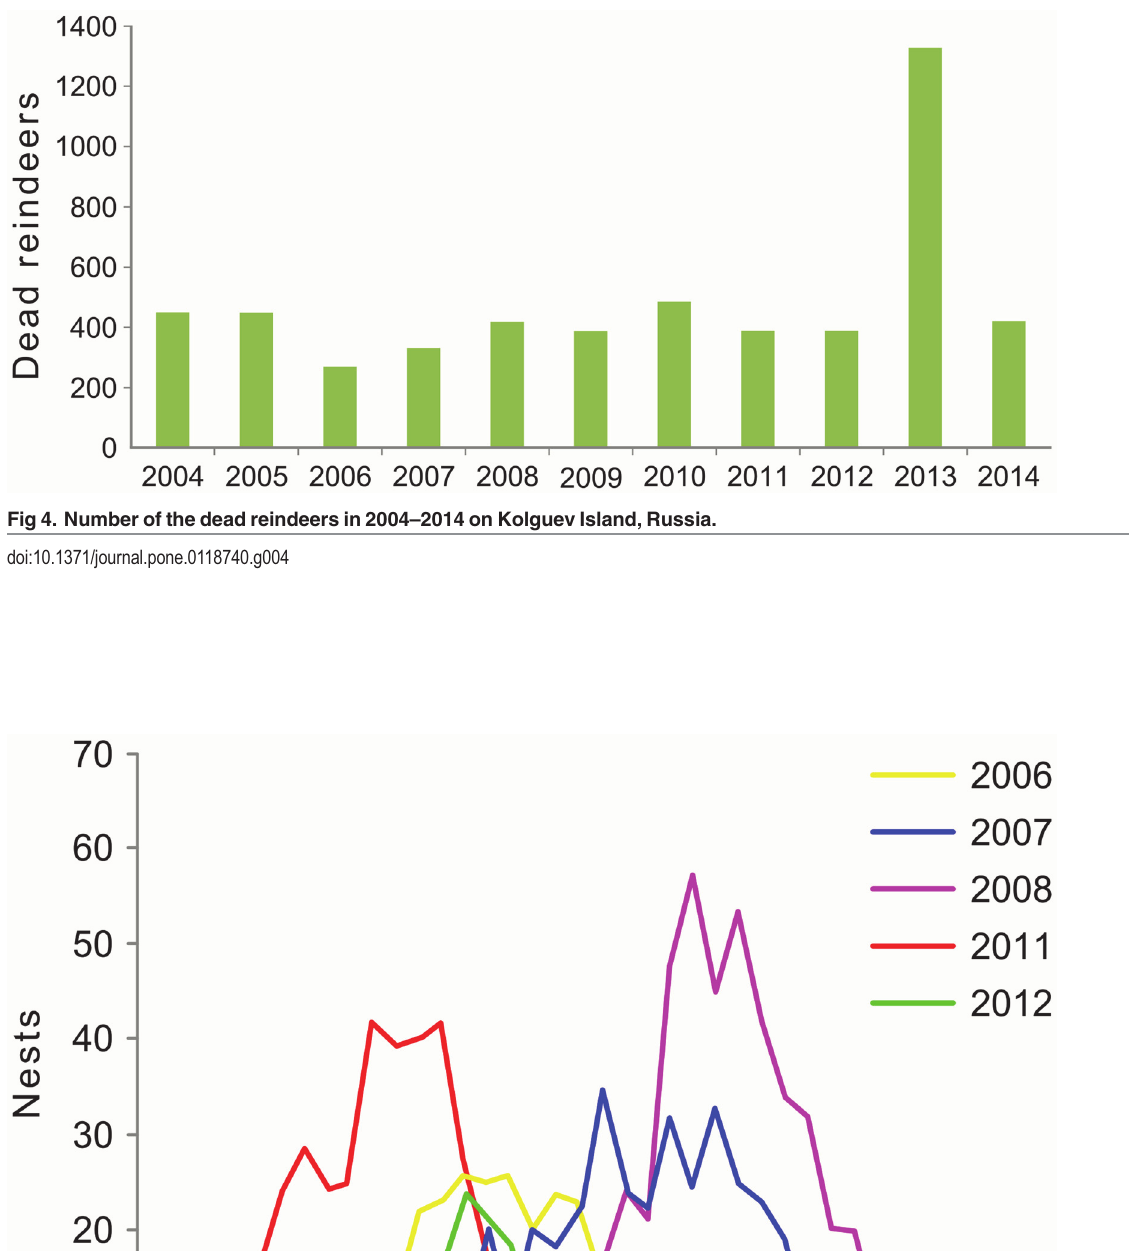
PLOS ONE | DOI:10.1371/journal.pone.0118740 February 18, 2015 10 /